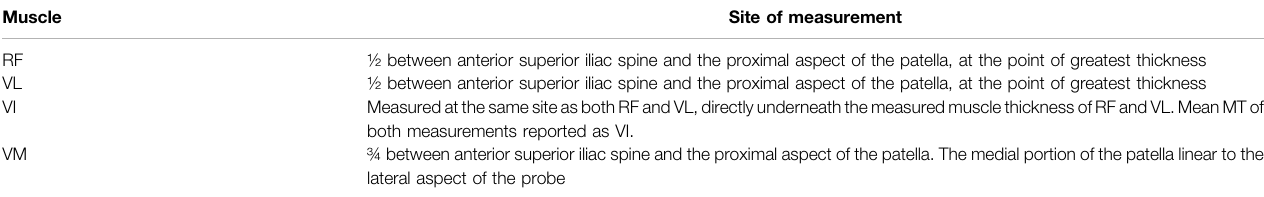
TABLE 1 | Sites of measurement and muscles measured at each site. Muscle Site of measurement